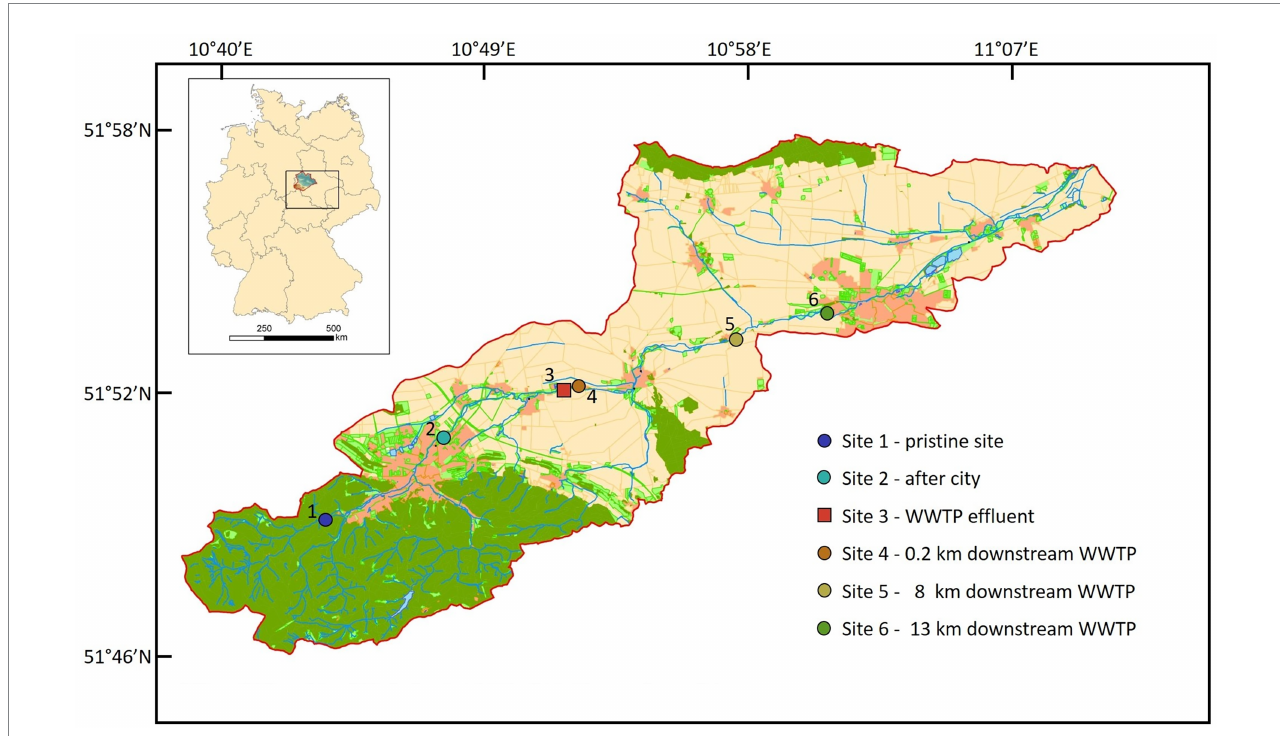
FIGURE 1 Location of all six sites in the catchment of the Holtemme river in the Harz mountain region, Germany. Map created from Authorative Topographic– Cartographic Information System